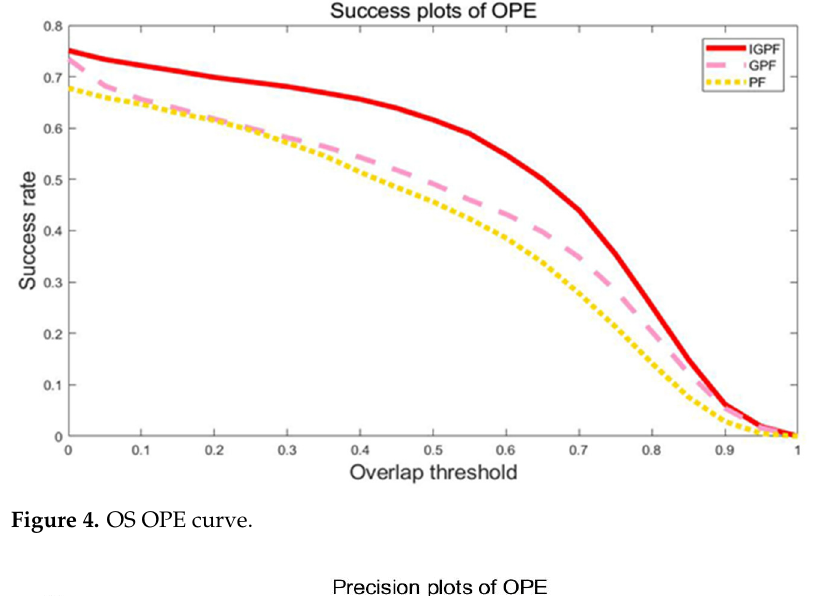
Figure 4. OS OPE curve.